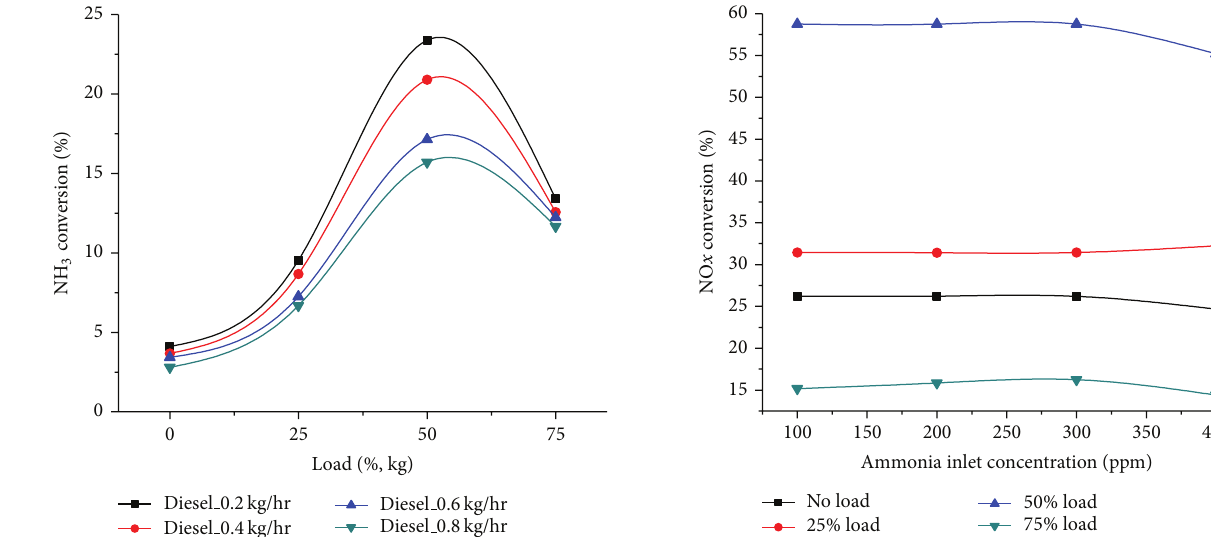
Figure 8: NH 3 conversion versus percentage of load.